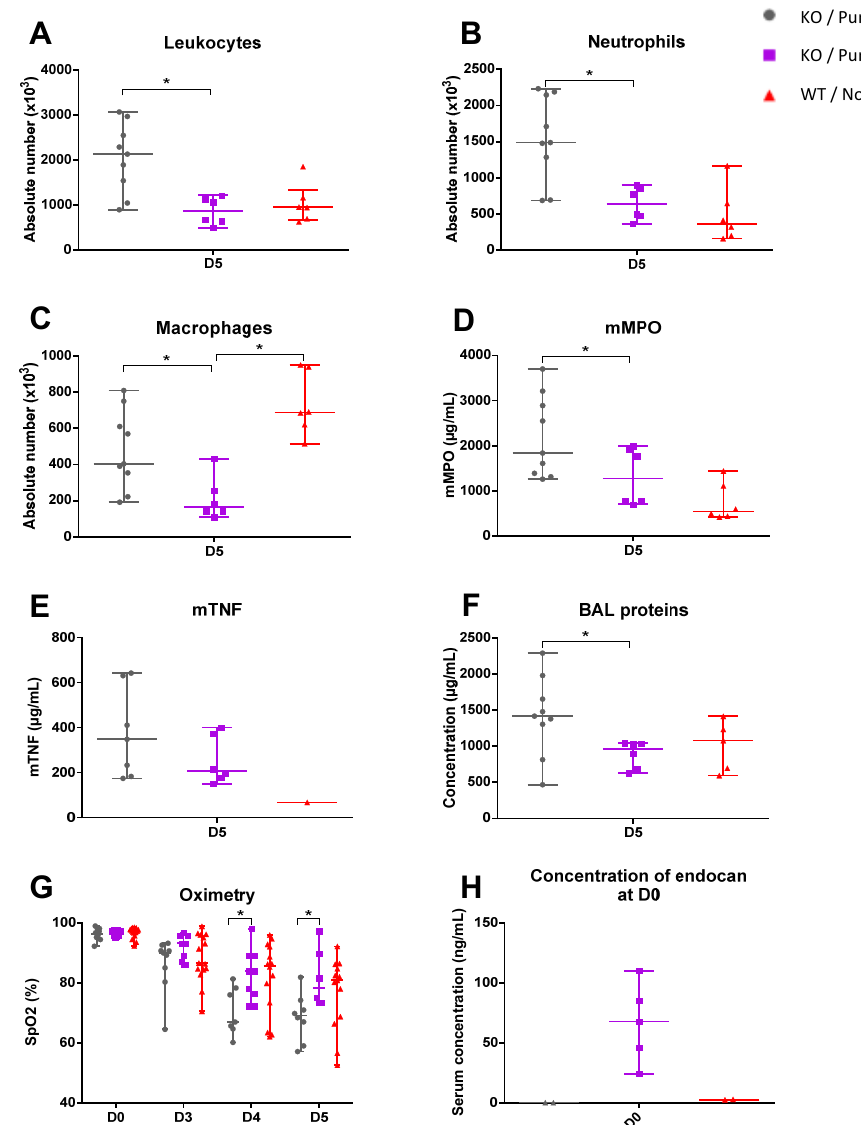
Figure 3. Continuous infusion of endocan reduces the inflammatory response and improves the pulmonary physiological function in Esm1 − / − mice. The inflammatory response on day 5 after intratracheal instillation of LPS in Esm1 − / − mice treated over 3 days by the continuous infusion of murine endocan (purple) compared to PBS (grey) and WT mice (red). BAL examinations are shown with absolute numbers of leukocytes ( A ), neutrophils ( B ), and macrophages ( C ). mMPO BAL concentrations are shown in ( D ), mTNF BAL concentrations are shown in ( E ), and protein BAL concentrations are shown in ( F ). Transcutaneous oximetry measurements at different times are shown in ( G ). The serum concentration of endocan at D0 is shown in ( H ). Data are represented by their median, 25th, and 75th percentile. ∆ is equal to the estimation of the effect of the group according to the linear mixed model test. * represents a p < 0.05 as the result of the Mann–Whitney test between the variables of each group at a specific timing.